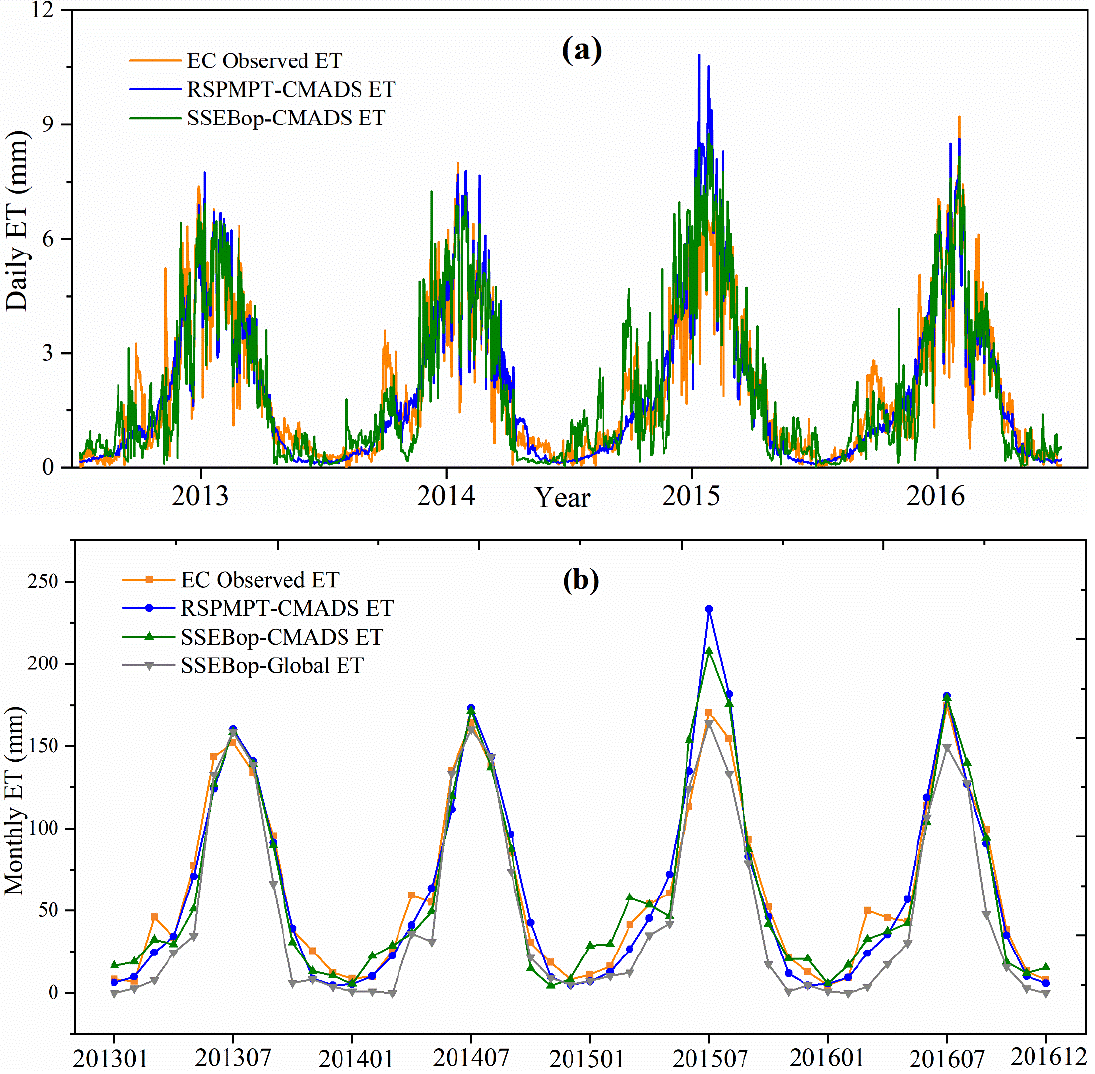
Figure 3. Comparisons of daily ET ( a ) and monthly ET ( b ) derived from different approaches with EC measured ground truth. Table 1. The overall performance statistics of daily and monthly ET estimations from 2013 to 2016.